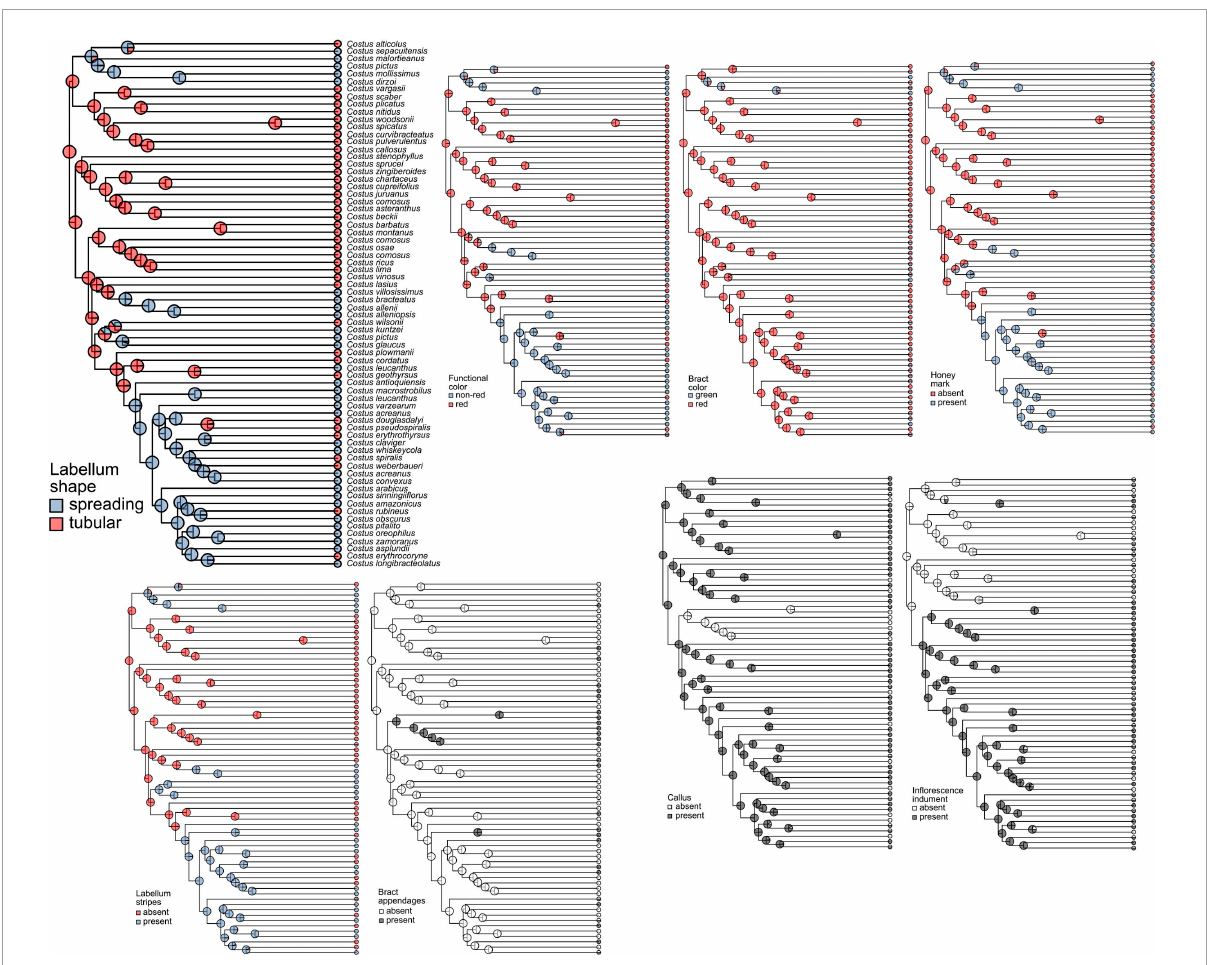
FIGURE3 Summary of the stochastic character mapping of the evolution of pollination and defense against herbivory traits in Neotropical Costus . Pie charts indicate the posterior probabilities obtained from the 1,000 stochastic mappings. Melittophily associated trait states are shown in blue and ornithophily associated trait states in red. Presence of traits associated with defense against herbivory are shown in gray and absence in